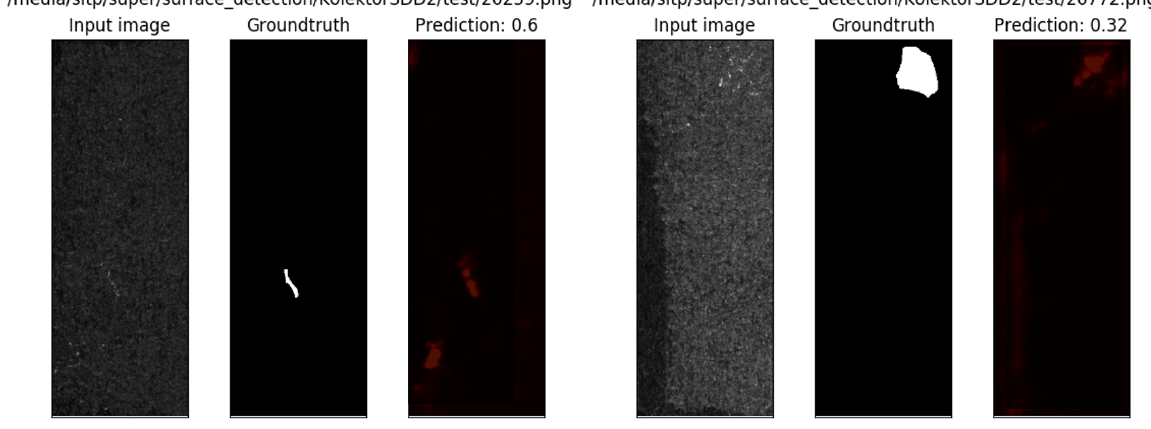
Figure 15. Examples of FN in